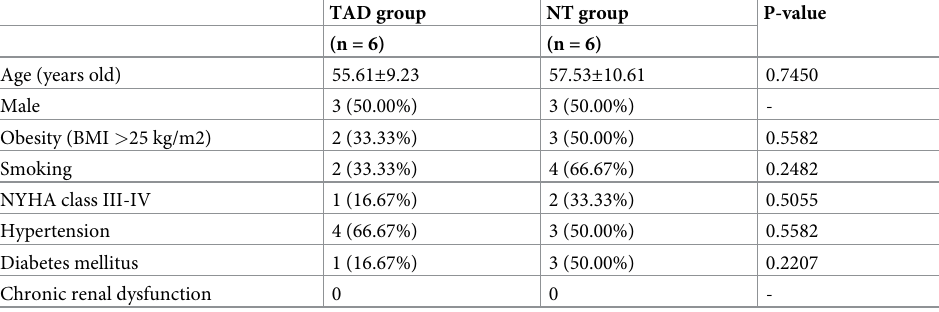
Table 3. General information for all